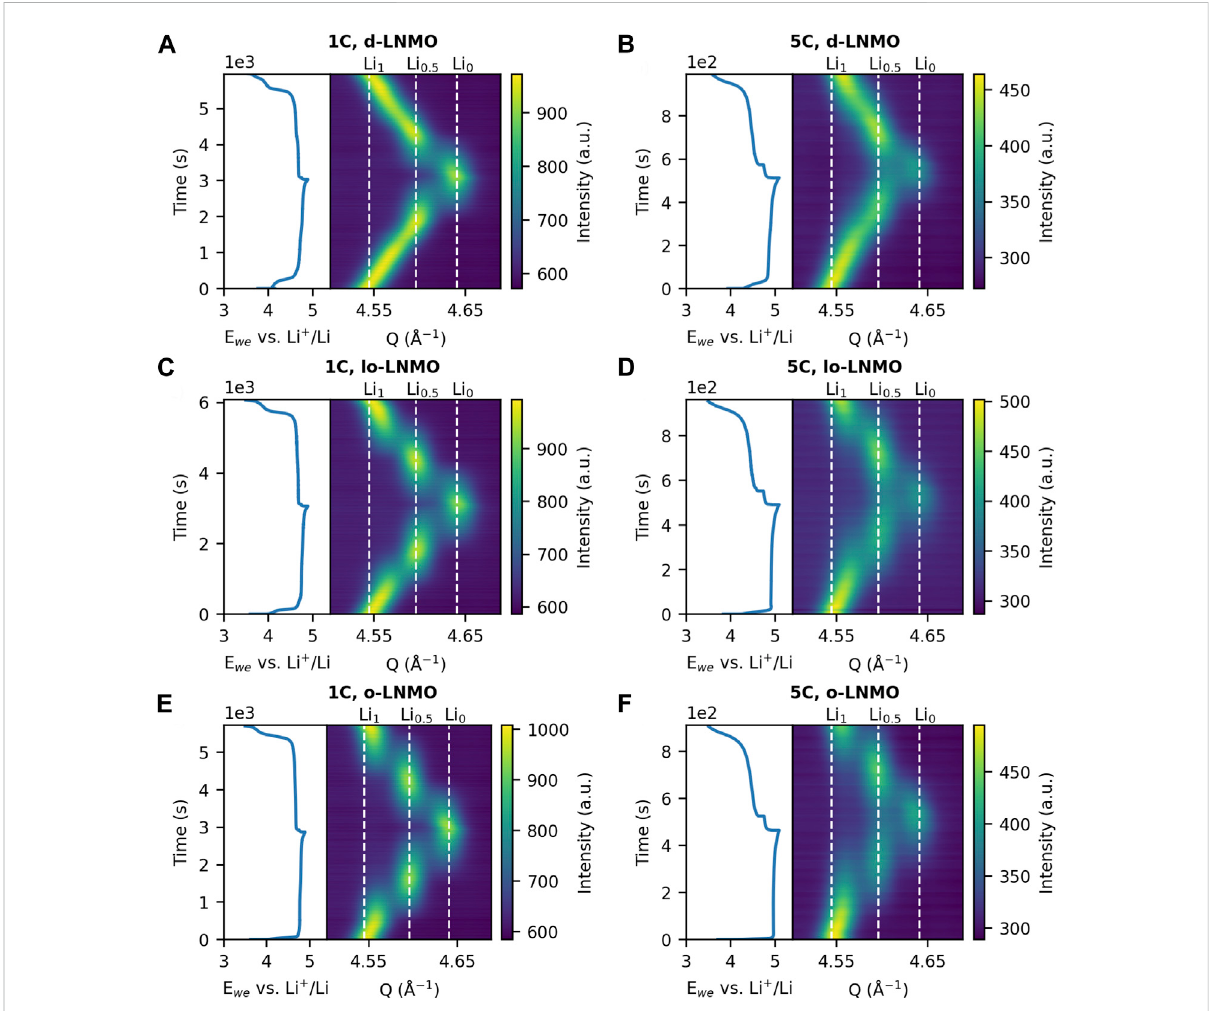
FIGURE 2 Change in Q of the (531) re fl ection during galvanostatic cycling at 1C and 5C of (A – B) disordered LNMO (d-LNMO), (C – D) less ordered LNMO (lo-LNMO) and (E – F) ordered LNMO (o-LNMO). The peak position of the intermediate phases LiNi 0.44 Mn 1.56 O 4 (Li 1 ), Li 0.5 Ni 0.44 Mn 1.56 O 4 (Li 0.5 ) and Ni 0.44 Mn 1.56 O 4 (Li 0 ) are indicated by the dashed white